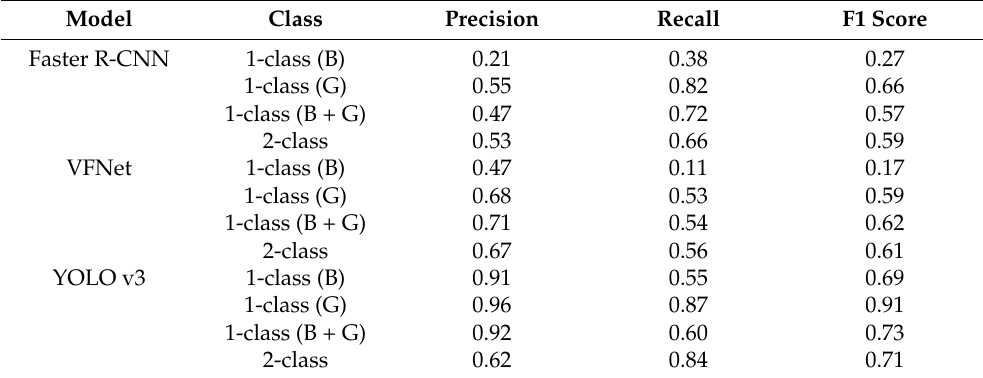
Table 2. Object detection neural network validation results for detection of weeds growing in alfalfa a